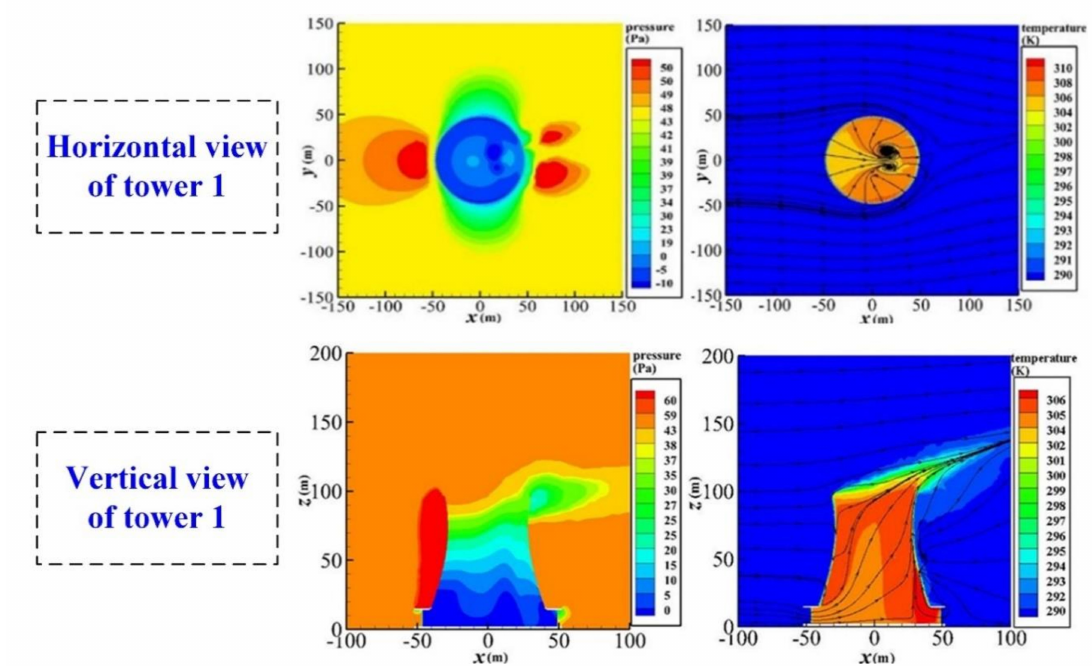
Figure 10. Air variable contours for steel-truss NDDCS with hyperbolic tower configuration at design crosswind of 4 m/s.